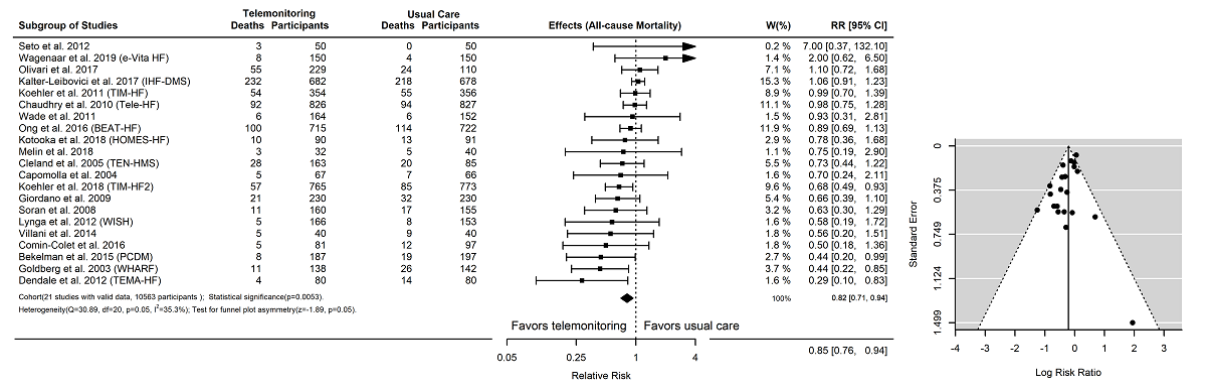
Figure 4. Event counts and effectiveness of telemonitoring interventions on all-cause mortality. There were 20 randomized controlled trials (N=10,263) with mortality event counts in the subgroup meta-analysis. RR: relative risk.